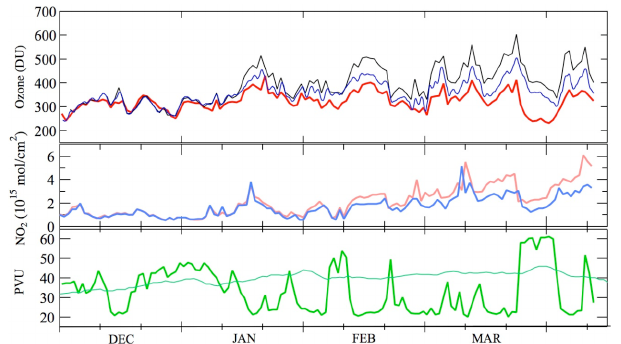
phase chemistry only (blue); SAOZ NO